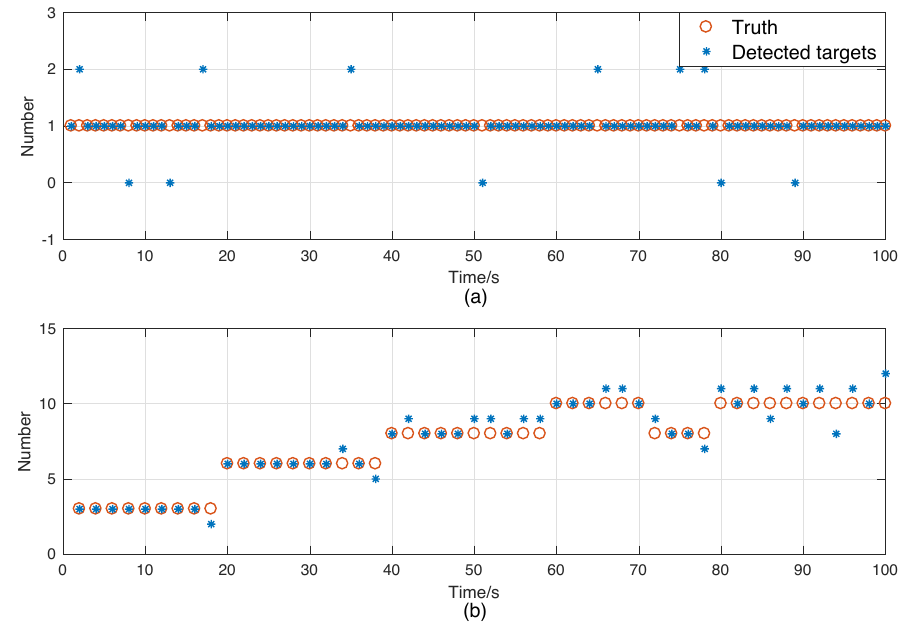
Figure 3. Number of detected targets. ( a ) Scenario 2. ( b ) Scenario